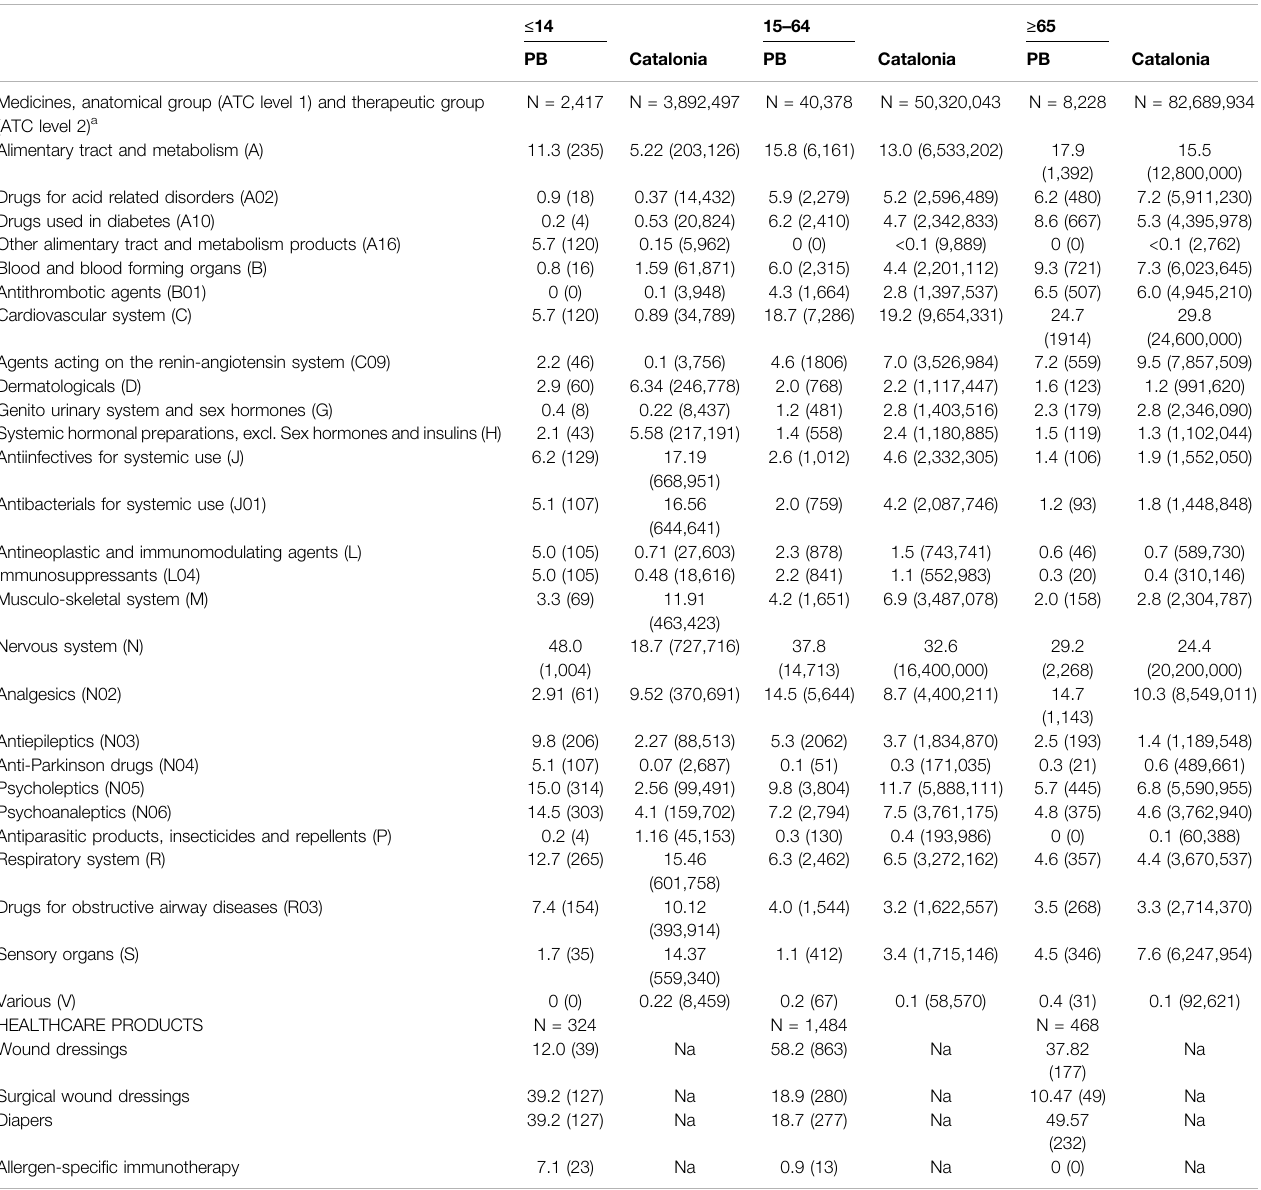
TABLE 5 | Proportion of medicines and healthcare products used by age group, %